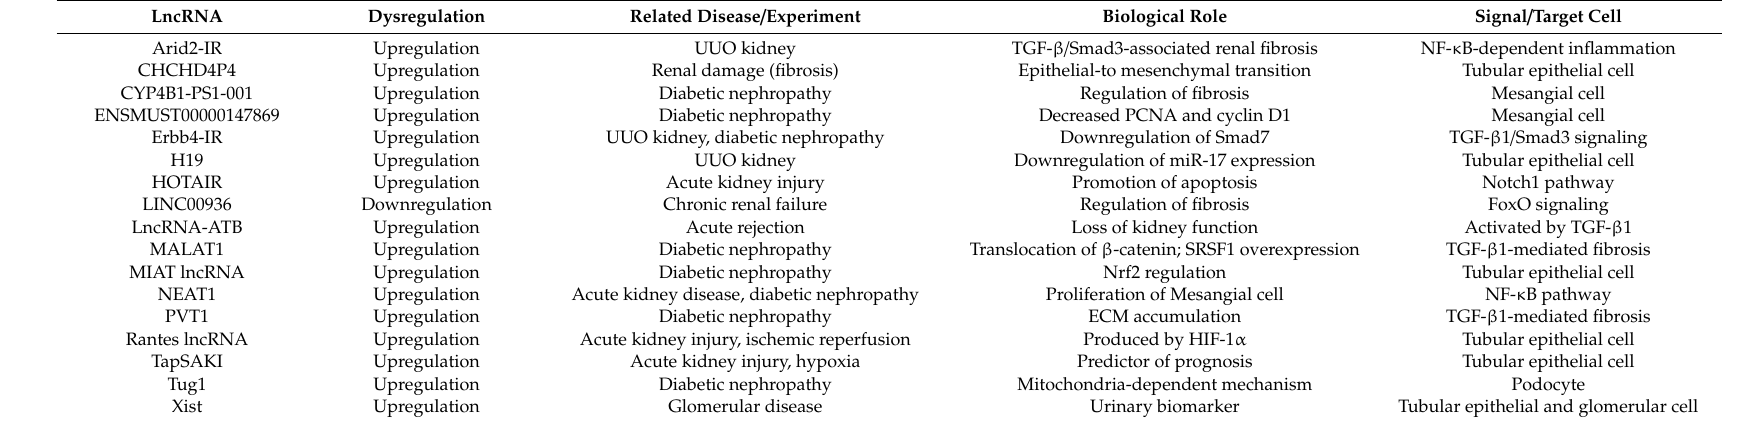
Table 1. LncRNAs related to renal